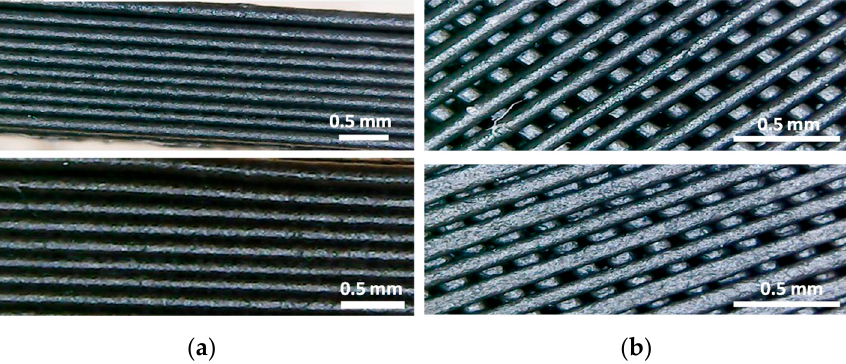
Figure 5. Optical micrographs of the ( a ) side and ( b ) upper surfaces of FFF-printed parts based on 30r-PP (upper panel) and 40r-PP (lower panel).